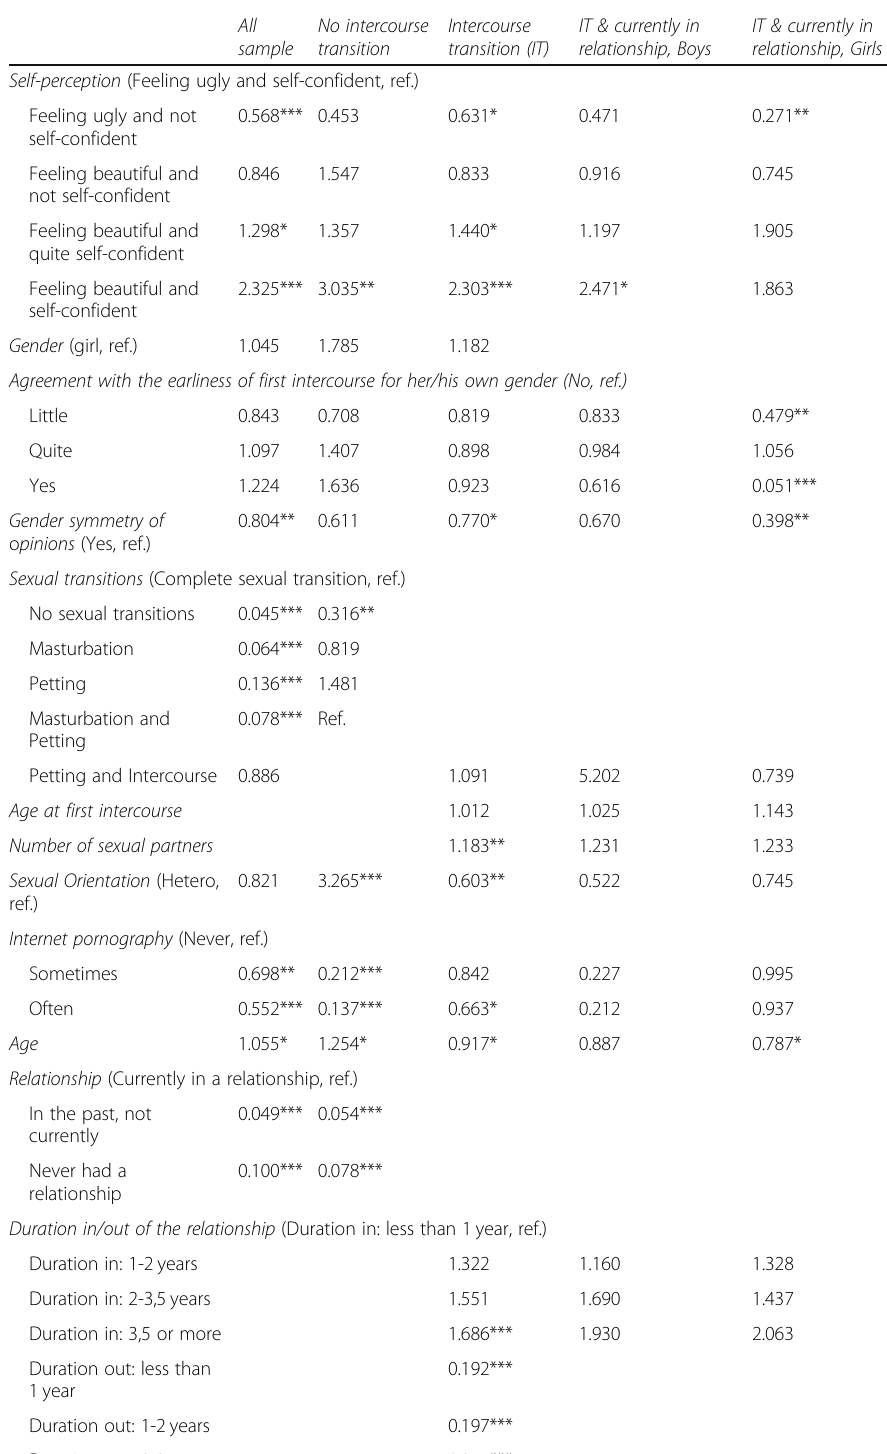
Table 3 Odds ratio of the logistic regression models with dependent variable sexual